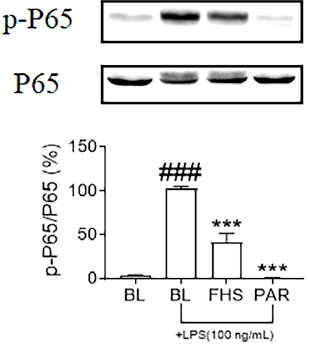
Figure 4. FHS suppressed the phosphorylation of P65. Cells were treated with FHS for 1 h and then incubated with LPS for another 10 min. The expression of p-P65 was analyzed by western blot and standardized with the total P65 ( n = 3). BL, medium without the addition of extracts; FHS, fermented hemp seed-containing medium’s supernatant of Day 7. ### p < 0.001 vs the control group; *** p < 0.001 vs the LPS-treated group.